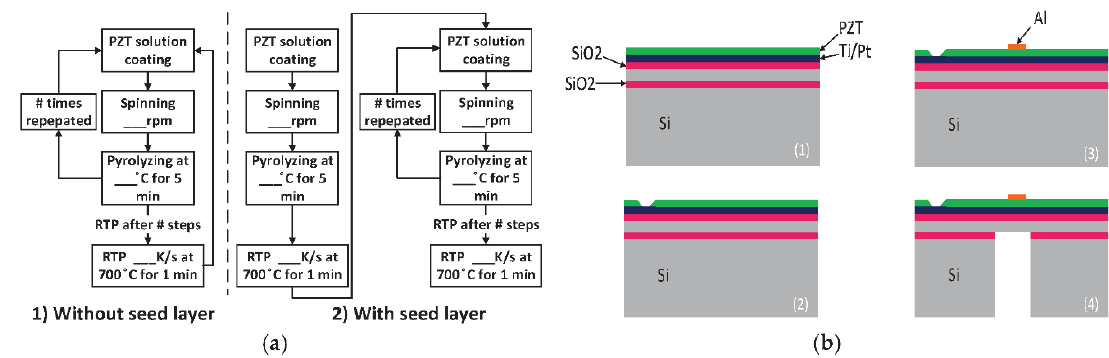
Figure 1. ( a ) Process flowchart of the PZT deposition (1) without and (2) with a seed layer deposition; ( b ) The fabrication process: (1) Deposition of the SiO 2 /Ti/Pt and PZT layer. The SiO 2 was deposited by wet thermal process as an isolation layer; (2) patterning of the PZT layer to access the bottom electrode. (3) Deposition and patterning of the top electrode. (4) Deep Reactive Ion Etching (DRIE) to release the PMUT membrane. (all electrodes were deposited by RF